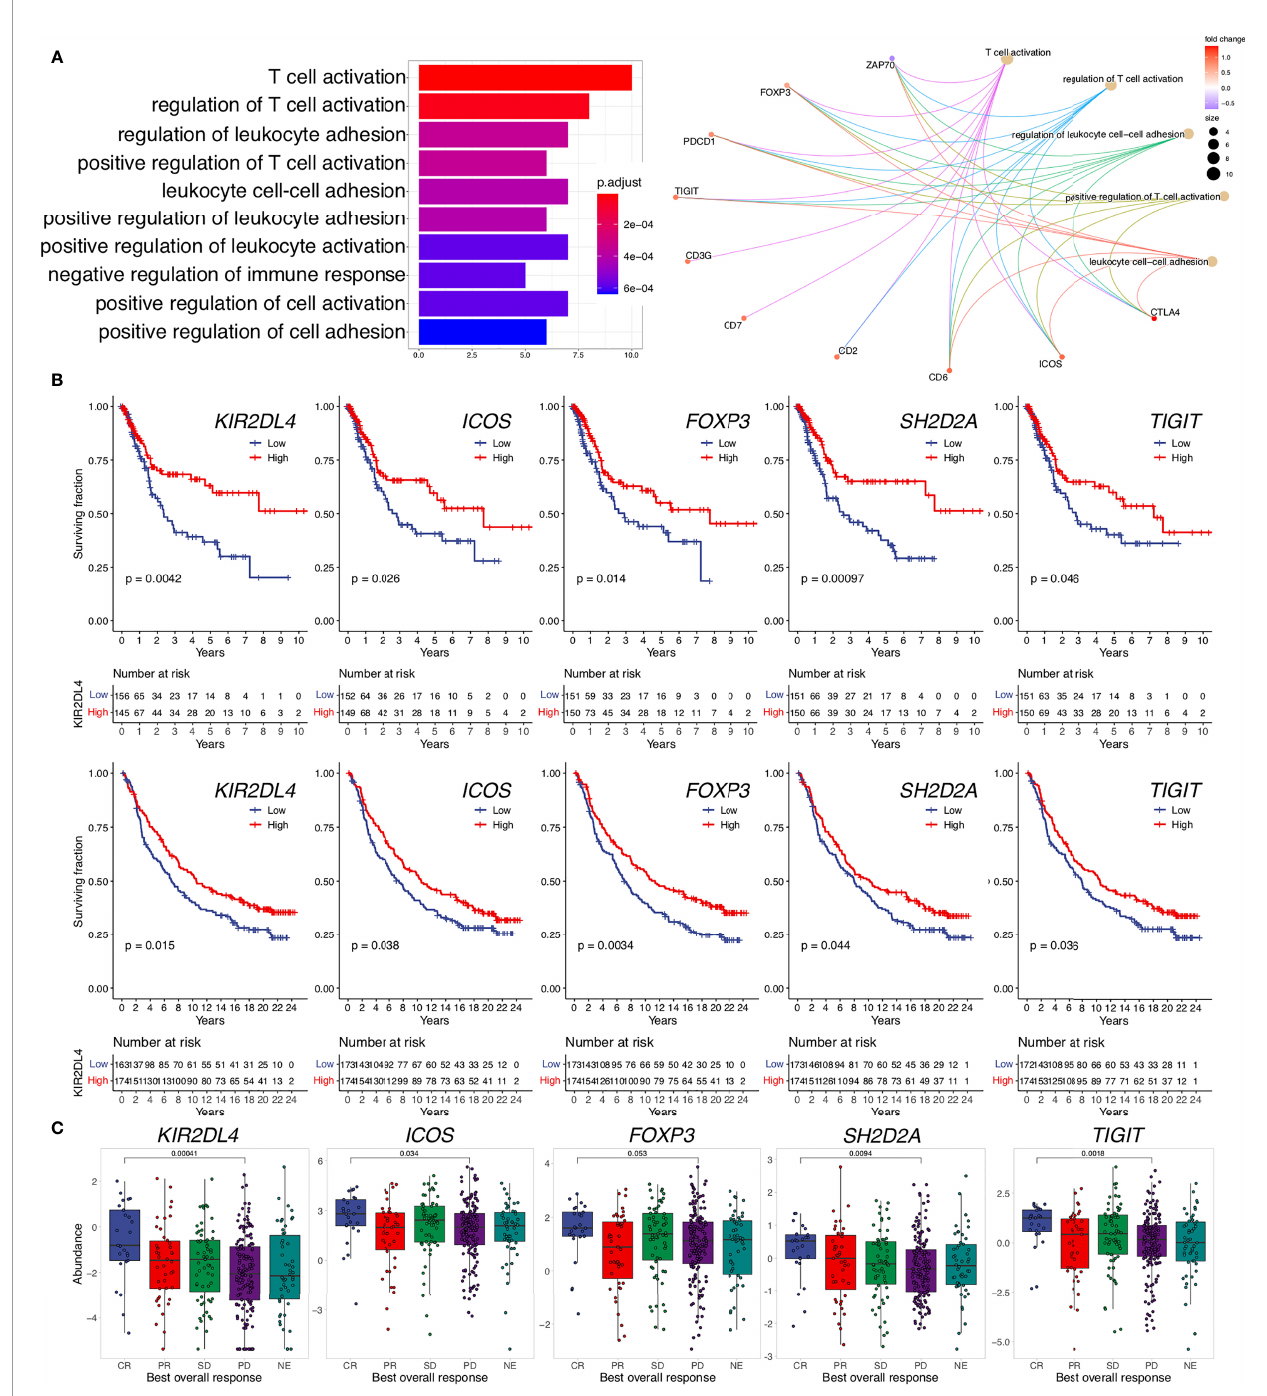
FIGURE 3 | Genes upregulated in TLS-high tumors are related to immune response activation, improved survival, and response to ICI. (A) Pathway enrichment analysis of TLS-associated DEGs unique to the d-TLS group comparison ( n = 44) was performed using gene ontology “ Biological Processes ” . The number of corresponding DEGs is visualized for the top ten enriched processes (left). The contribution of speci fi c genes to the top fi ve enriched pathways is visualized (right). (B) Overall survival was compared for gene expression groups de fi ned by cohort medians in the TCGA MIBC cohort (top row) and IMvigor210 cohort (bottom row) using Kaplan – Meier curve and log-rank test for each unique DEG. (C) Expression comparison of the identi fi ed unique DEGs between complete response (CR) and progressive disease (PD) after ICI in the IMVigor210 dataset was performed by two-tailed t -test. Genes that showed signi fi cant favorable prognostic associations in both cohorts are